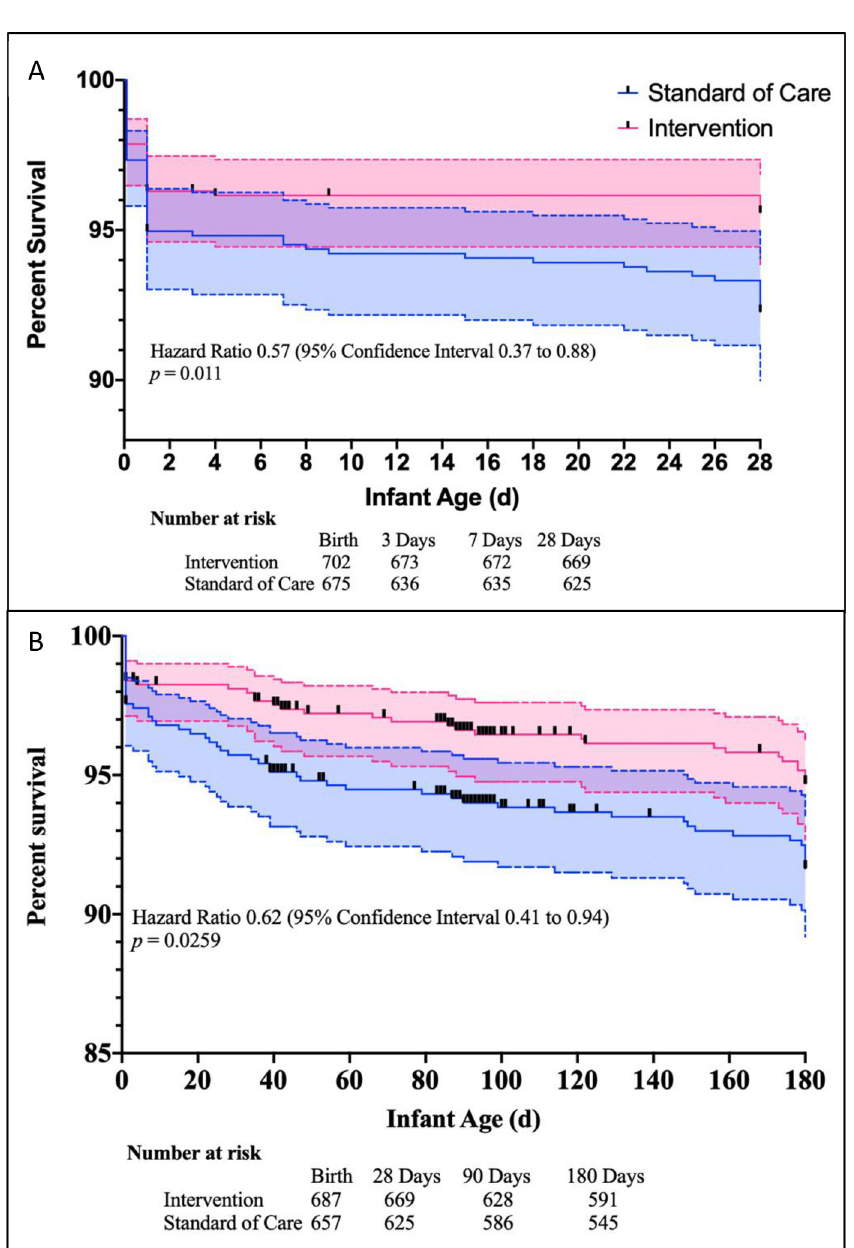
methods and compared with Mantel–Haenszel test. Panel A demonstrates the survival curve for perinatal and neonatal mortality. Panel B demonstrates infant mortality from birth until 6 months of